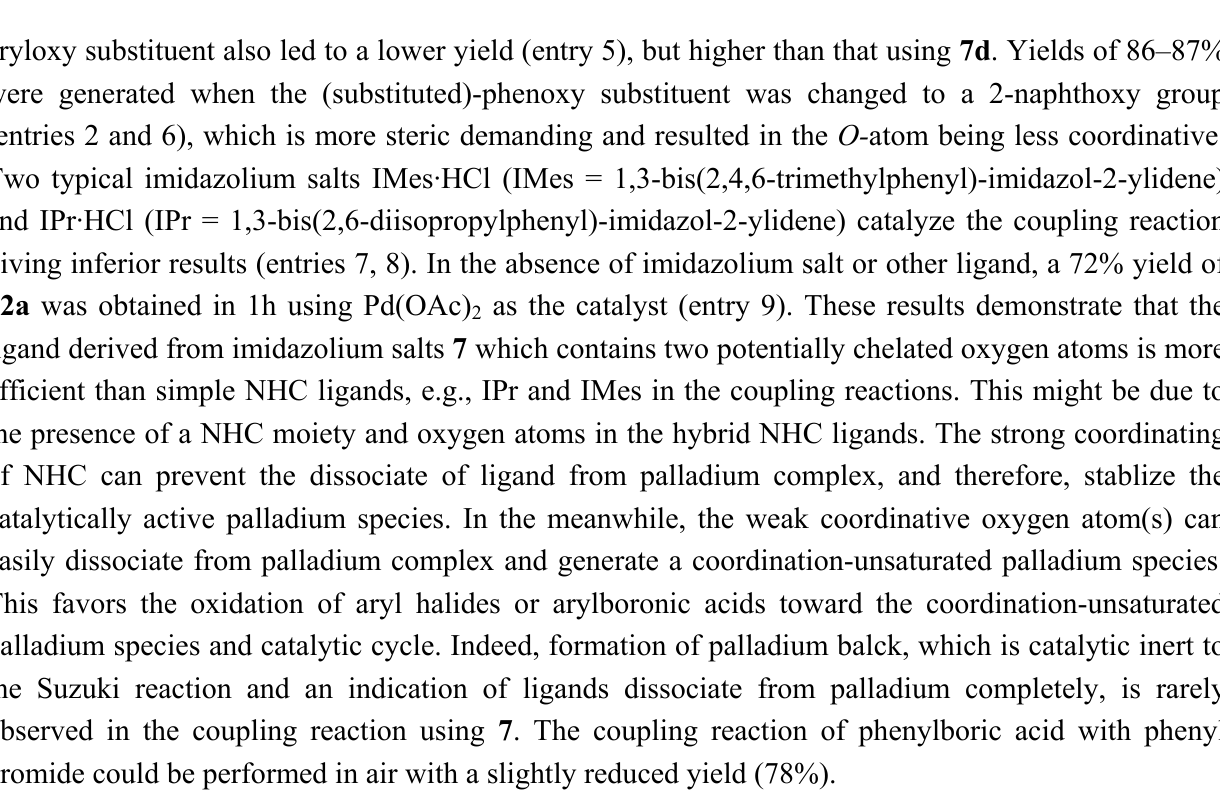
Table 2. Evaluation of the NHCs from 7a – f in the Suzuki-Miyaura reaction a .